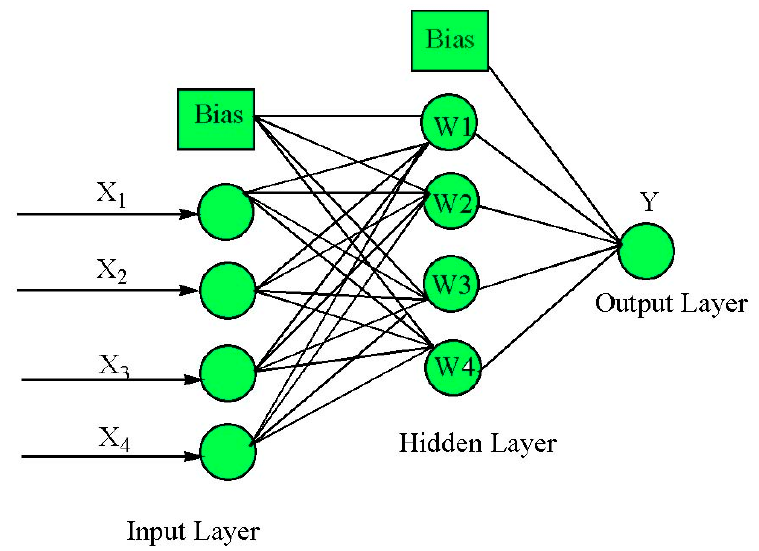
Figure 3. Pattern of optimized ANN architecture (4-4-1).